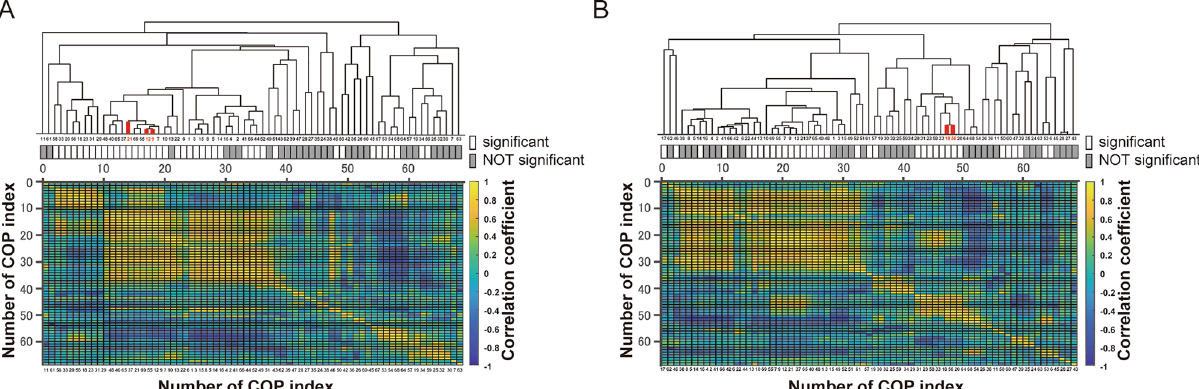
Figure 3. Correlation matrix and the dendrogram of all pairwise COP indices. The correlation matrix and the dendrogram by the hierarchical cluster analysis for 69 COP indices in the Foam ( A ) and EC ( B ) conditions. Thick red lines represent the informative predictors in each condition (the Foam condition; Velocity AP, SD of COMacc AP, and SD of Velocity AP extracted in the Foam, the EC condition; Mean-cross AP, MFREQ AP). The correlation coefficients between 2 indices for all combinations are pictured with the color map, which was used as the